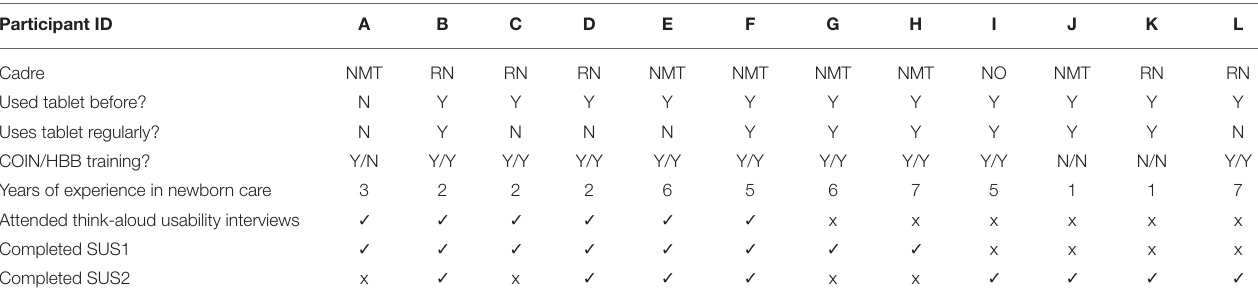
TABLE 3 | Demographic details and professional and training experience of participants attending think aloud app usability sessions (age and gender are excluded for confidentiality). Participant